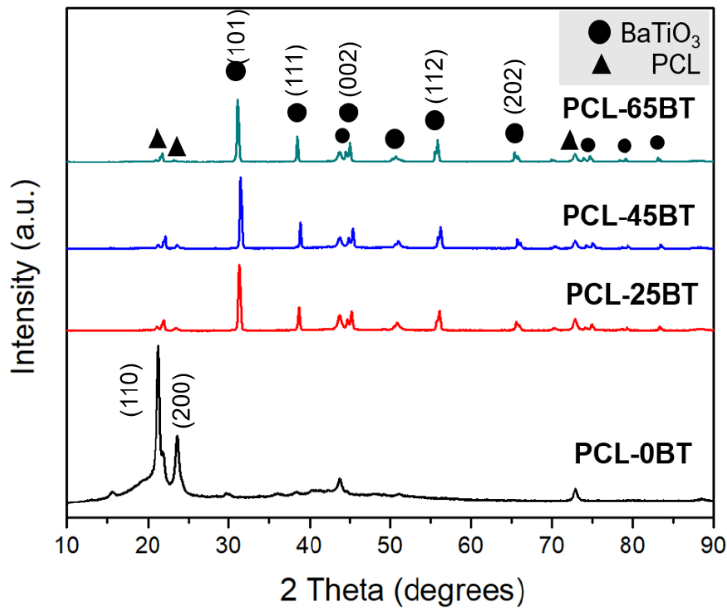
Figure 6. X-ray diffraction (XRD) of the PCL-BT composite scaffolds with various concentrations of BaTiO 3 .